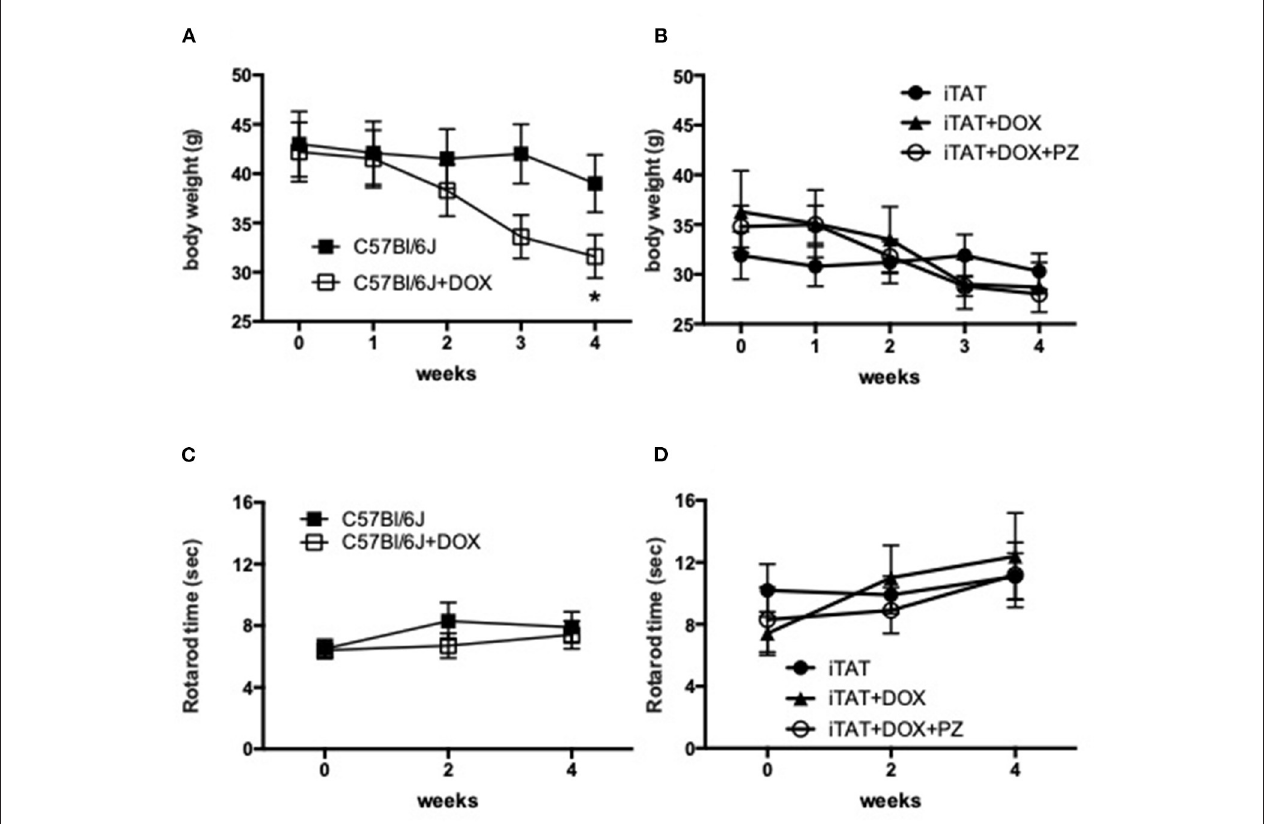
FIGURE 1 | Body weight and sensorimotor function. (A) Body weight in C57Bl6/J mice treated with vehicle (filled squares) or DOX (open squares). (B) Body weight in TAT transgenic mice treated with vehicle (filled circles), DOX (filled triangles) or DOX and PZ (open circles). (C) Rotarod performance in C57Bl6/J mice treated with vehicle (filled squares) or DOX (open squares). (D) Rotarod performance in TAT transgenic mice treated with vehicle (filled circles), DOX (filled triangles) or DOX and PZ (open circles). Data are group mean of N = 6–9/group ± SEM. Statistical comparisons by two way repeat measures ANOVA followed by Dunnett’s post-hoc test. * p < 0.05 vs. within group time